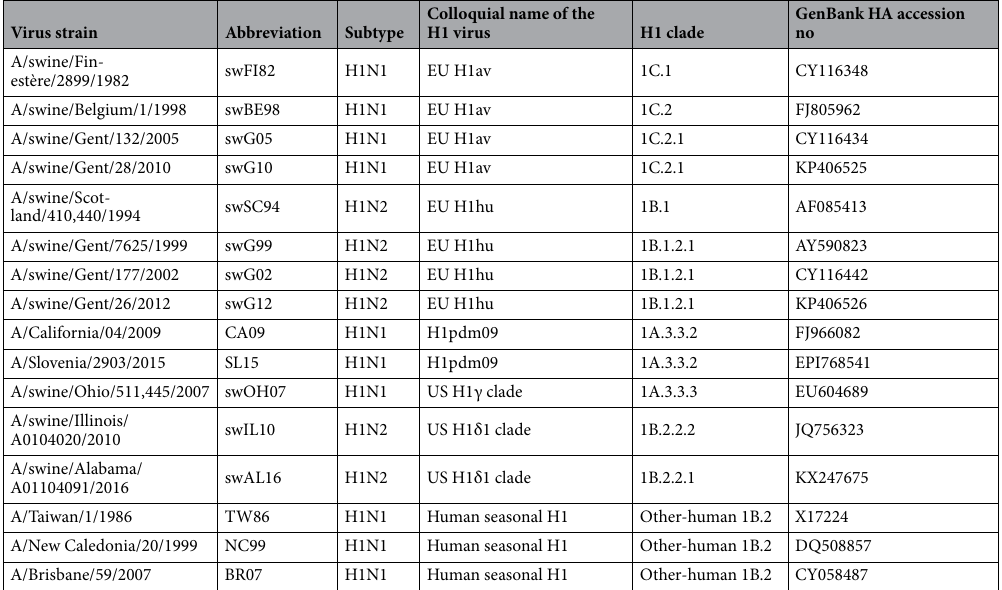
Table 1. Reference influenza A virus strains used for genetic and antigenic characterization of the hemagglutinin (HA) of swIAV isolates. EU H1av—European avian-like H1; EU H1hu—European human-like H1; H1pdm09—2009 pandemic H1; US H1γ—United States of America H1 gamma clade; US H1δ1—United States of America H1 delta 1